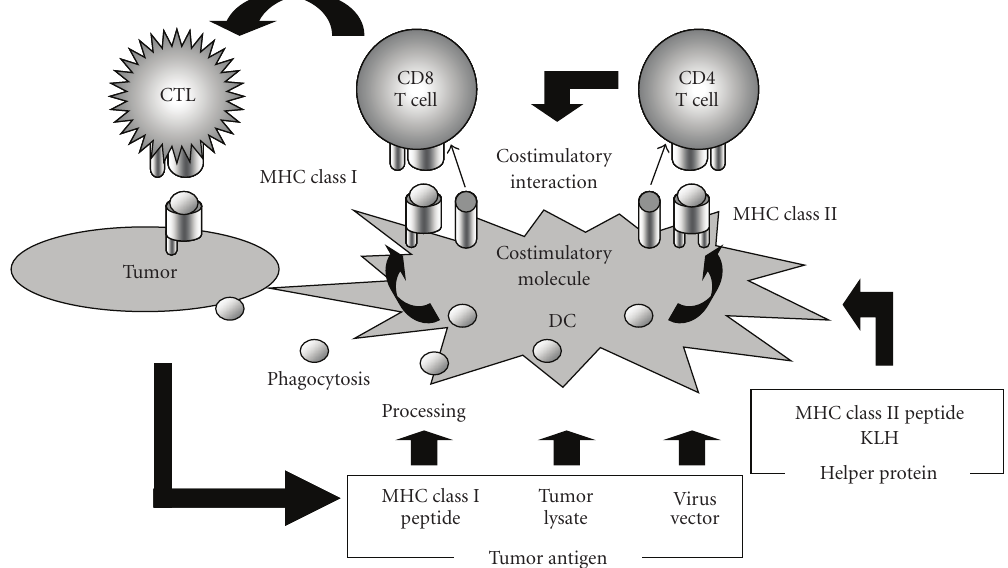
Figure 1: CTL induction by Apcs. Antigens are taken up and degraded into peptide fragments by antigen presenting cells (APC), such as immature DC. At some point on their path to the cell surface, newly synthesized MHC class II or I molecules bind the peptide antigen fragments and transport the peptides to the cell surface. CD8 + T cells recognizing the antigen expressed by weakly costimulatory cells become activated only in the presence of CD4 + T cells bound to the same APC. This happens via CD4 + T cells recognizing antigens presented by APCs and being triggered to induce increased levels of costimulatory activity by the antigen-presenting cell. The CD4 + T cells also produce increased amounts of IL-2, which drives CD8 + T cell proliferation. CD8 + T cells then become cytotoxic T lymphocytes